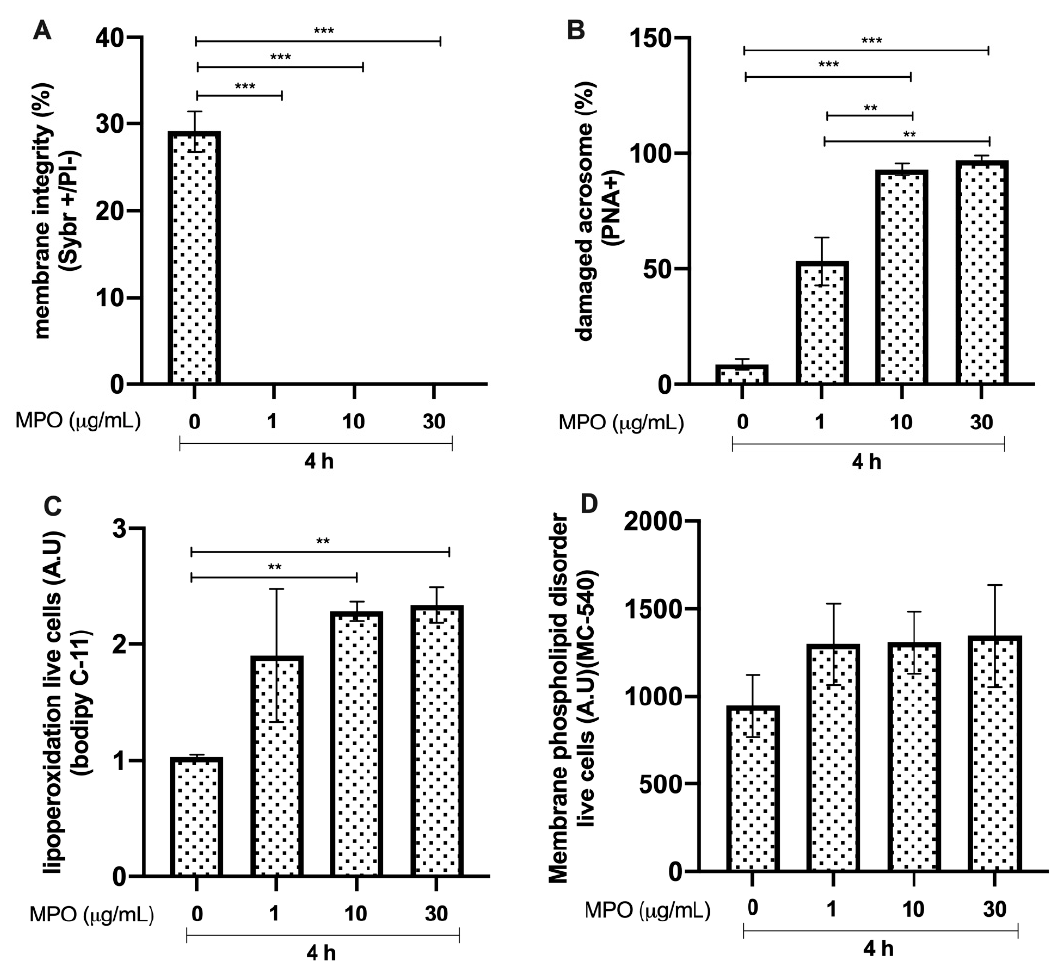
Figure 3. Effect of different concentrations of myeloperoxidase (MPO) on bull sperm. ( A ) Plasma membrane integrity. ( B ) Damaged acrosomes. ( C ) Lipid peroxidation. ( D ) Membrane phospholipid disorder. The results are shown as the mean ± standard deviation. The asterisks (**, ***) above the bars indicate differences between the groups ( p < 0.01, and p < 0.0001) based on three biological replicates.